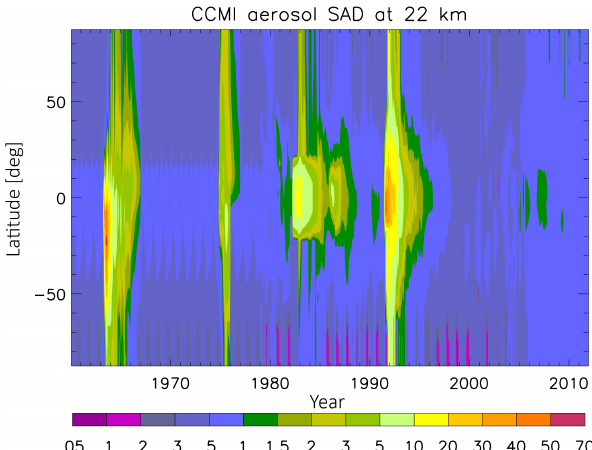
Figure 5. Zonal-mean aerosol surface area density (µm 2 cm − 3 ) at 22km. The discrete events are due to volcanic eruptions, superim- posed on a much smaller non-volcanic